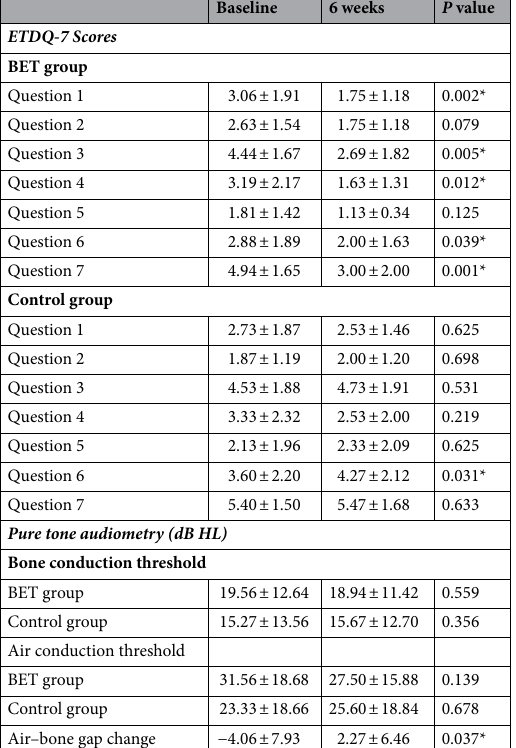
Table 3. Changes in ETDQ-7 scores and pure tone audiograms in both group. * P < 0.05, ETDQ, Eustachian tube dysfunction questionnaire; BET, balloon Eustachian tuboplasty; dB, decibel; HL, hearing level.